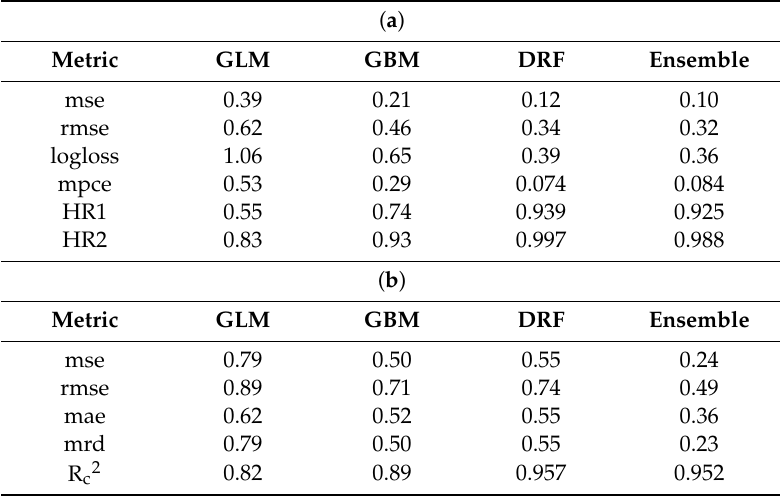
Mse, mean standard error; rmse, root mean square error; logloss, logarithmic loss; mpce, Mean Per-Class Error; HR1, within class; HR2, within 2 classes; mae, mean average error; mrd, mean residual deviation; R c , Pearson’s correlation coe ffi